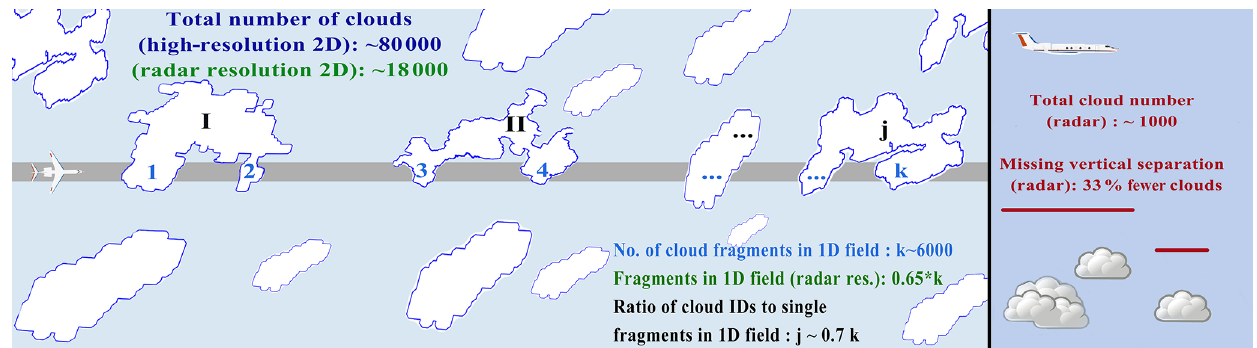
Figure 5. Quantitative impact on cloud counting during NARVAL II when including the second dimension in the across-track (left) and vertical (right) for imager and radar. On the left, the roman numbers represent ID-labelled clouds reaching into the radar curtain (grey swath is not true to scale). Arabic numbers (in clouds) represent distinct cloud fragments reaching into the radar FOV. On the right, the vertical distinction between overlapping clouds shows similar increases. Numbers outside the clouds refer to the entire synergy period (specified in Sect. 3).